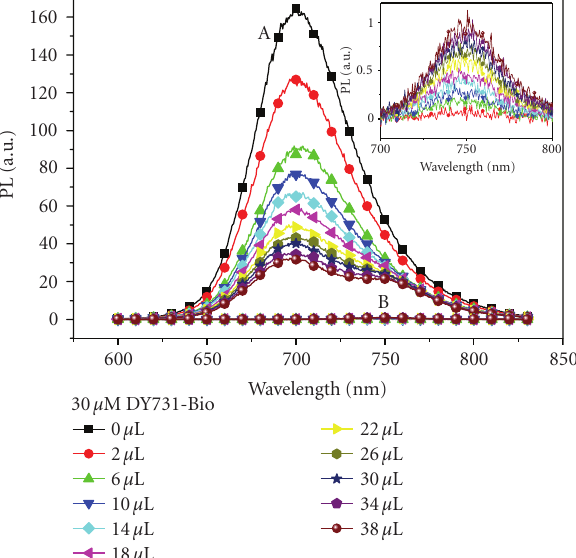
Figure 3: Spectra A are the composite photoluminescence of the Qdot705-STV and DY731-Bio mixtures in a series of DY731-Bio titrations. Spectra B are the control photoluminescence of pure DY731-Bio solutions with the equal molar concentration of DY731 as that in the former mixtures. An expanded view of the control spectra is shown in the